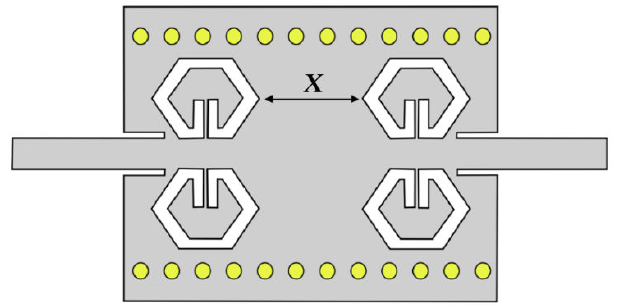
FIGURE 6. The tunable BPF with 04 C-HMC cells. The value of X is 5.1 mm.